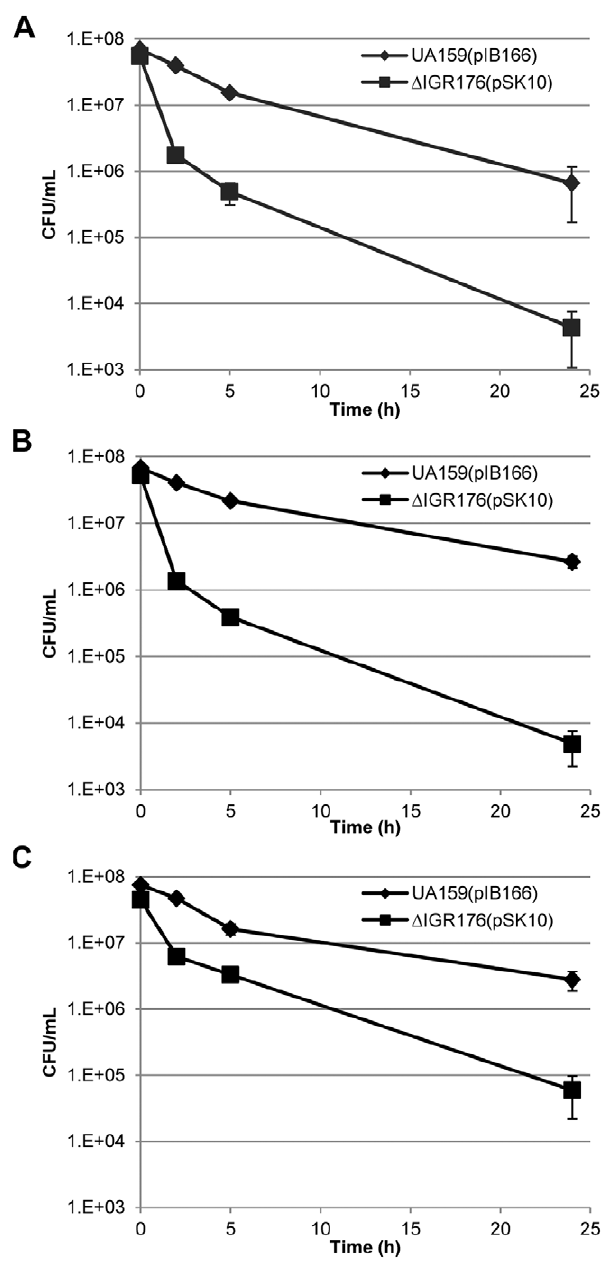
Figure 6. Effects of mild-overexpression of Fst-Sm/srSm type I TA system on S.mutans persister formation. Oxacillin-treated ( A ), cefotaxime-treated ( B ), and vancomycin-treated ( C ) cells were removed at the indicated time points, serially diluted, spot plated onto THYE agar plates, and the number of CFU per ml was determined from plate counts. The curves presented are the averages and standard deviations of results from three independent cultures. difficulty in predicting the antitoxin small RNAs [4]. In the present study, we reported to our knowledge the first functional type I TA system in streptococci. TAs are commonly described as constit- uents of the prokaryotic mobilome [4]. The chromosomal fst-Sm / srSm locus is located in a transposon-related genomic island of S.